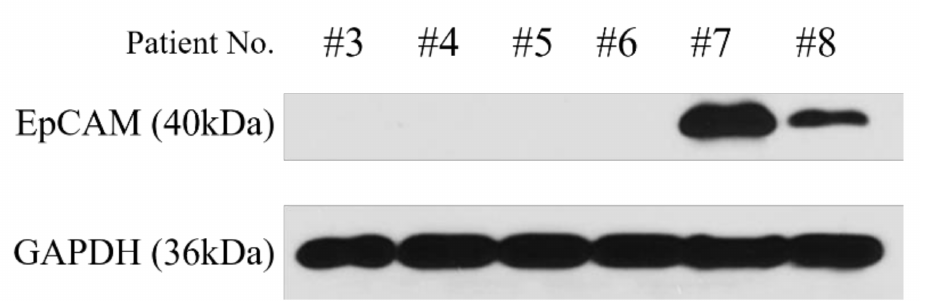
Figure 7. EpCAM expression using Western blot in MCTS. For the original Western blots, see Supplementary Figure S1. Different expression of EpCAM was assessed by Western blot analysis in